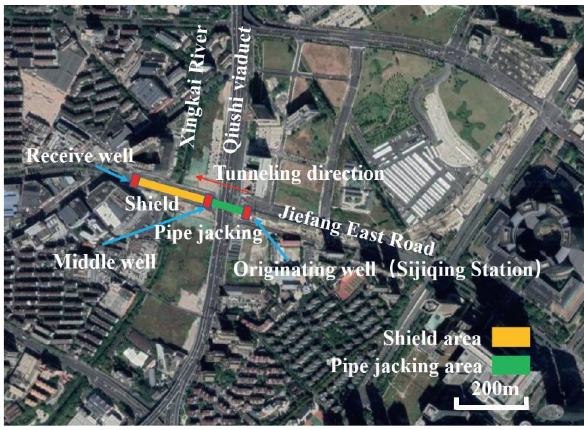
Figure 1: Tunnel location